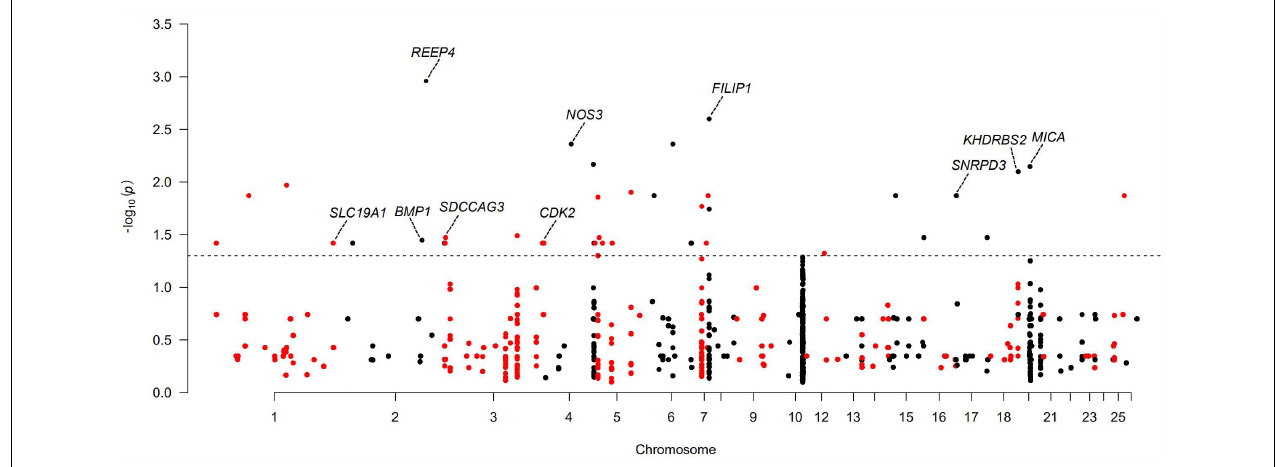
FIGURE 5 | Manhattan plots of genome-wide association study (GWAS) of large litter size for Wadi, Hu, Finnsheep, Icelandic, and Romanov and smaller litter size for Texel. The threshold of adjusted P < 0.05 is indicated by a dotted line.